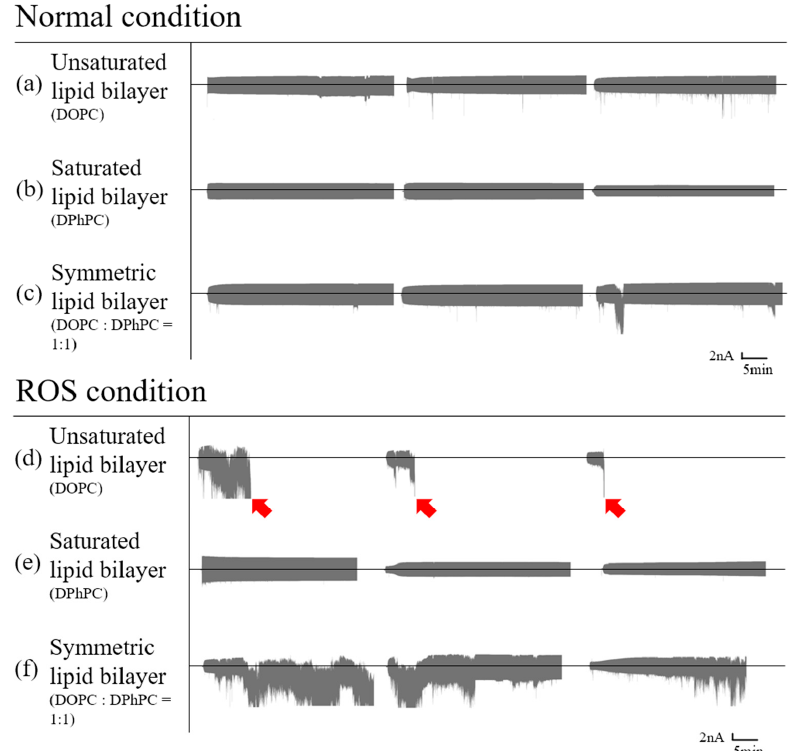
Figure 1. Symmetric planar lipid bilayer electric current graph with a triangle wave voltage; the middle line of each chart is zero amperes (Figure S4). Red arrows indicate that the droplets no longer remain intact. Lipid bilayer in the absence of ROS (unsaturated; ( a ), saturated; ( b ), mixed; ( c )) and the presence of ROS (unsaturated; ( d ), saturated; ( e ), mixed; ( f )).